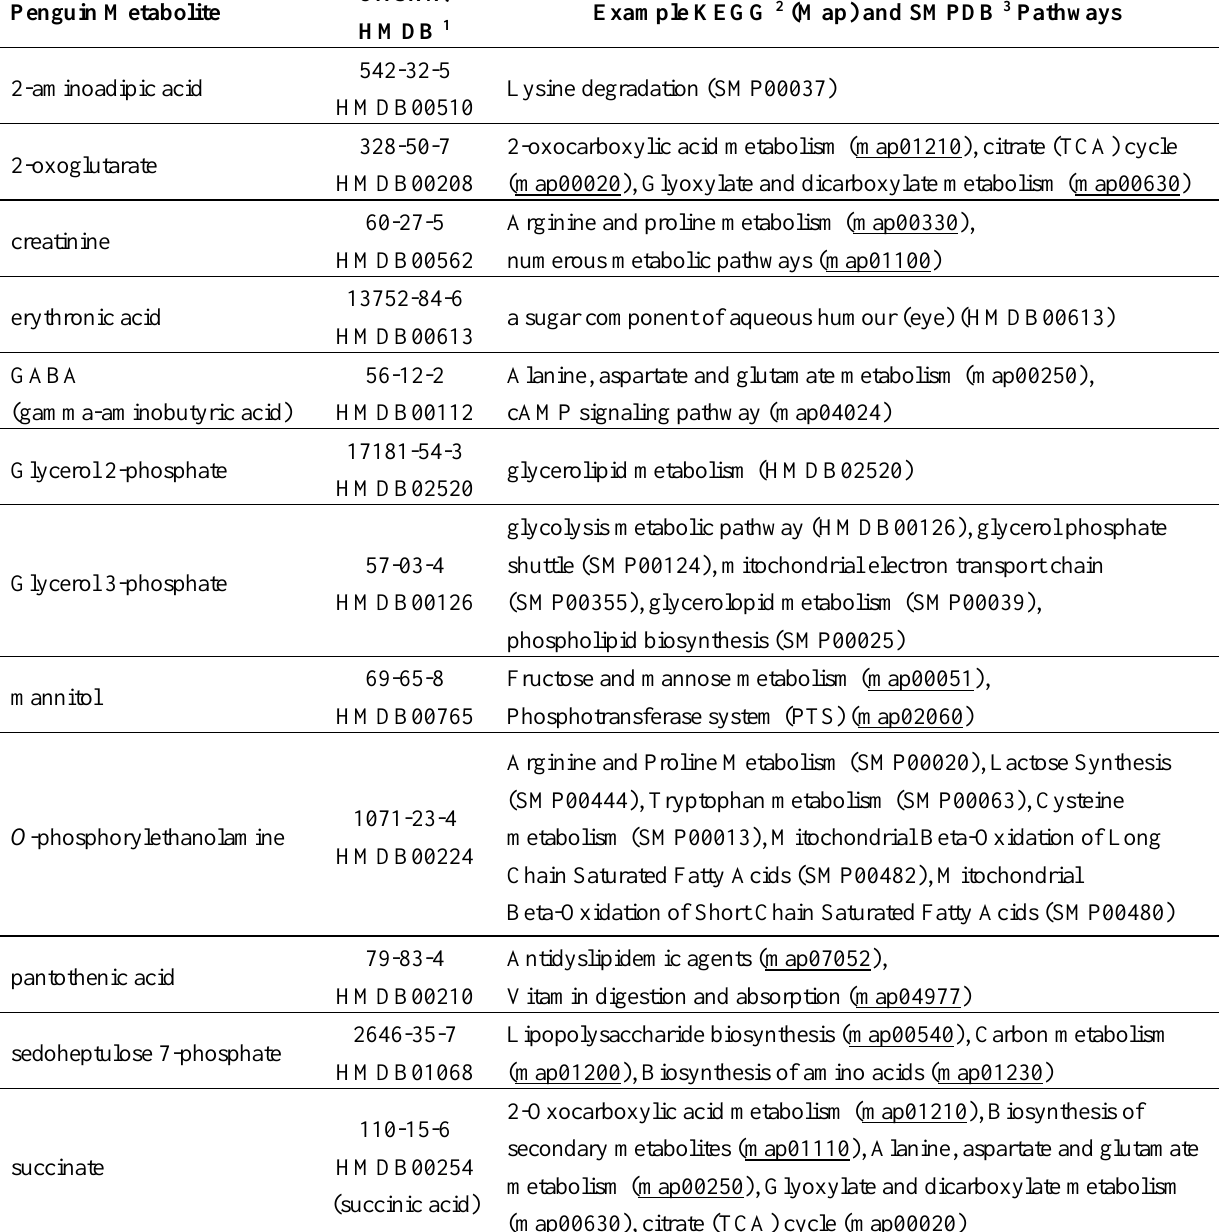
Table 1. Penguin metabolites with statistically significant gender dimorphism and example metabolic roles in